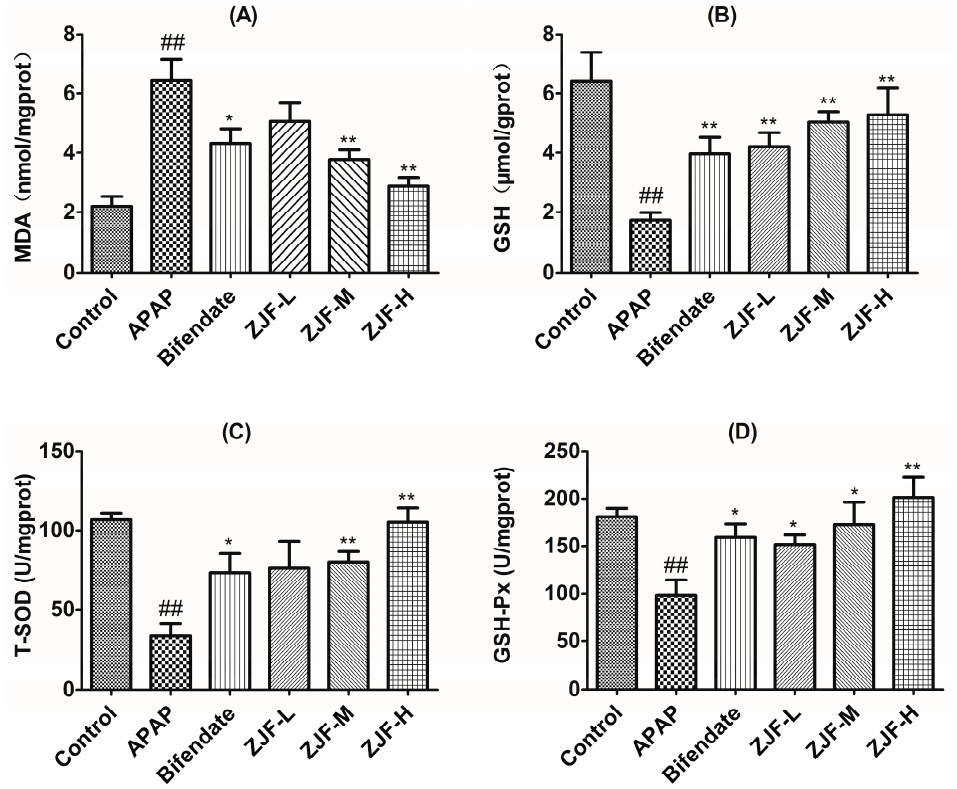
Figure 4. Effects of ZJF on the oxidative damage markers in liver homogenate after APAP overdose. ( A ) Hepatic level of malondialdehyde (MDA); ( B ) Hepatic glutathione (GSH) contents; ( C ) Hepatic superoxide dismutase (SOD) activity ( D ) Hepatic glutathione peroxidase (GSH-Px) activity. Data are expressed as mean ± SEM, n = 6 mice per group. ## p < 0.01 vs. the control group. * p < 0.05 and ** p < 0.01 vs. the APAP group.